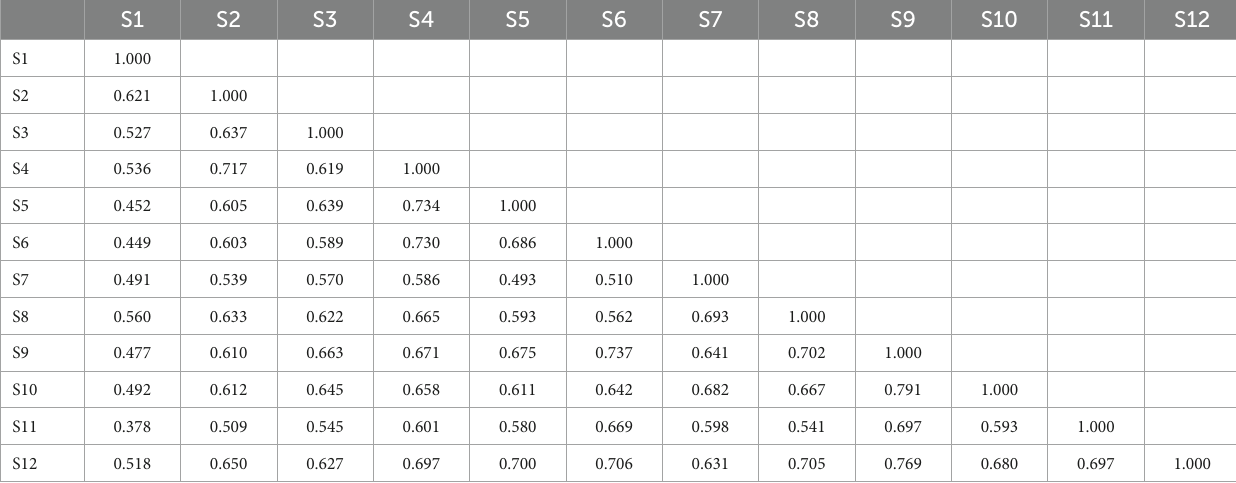
TABLE 3 Correlation matrix for the observed variables.